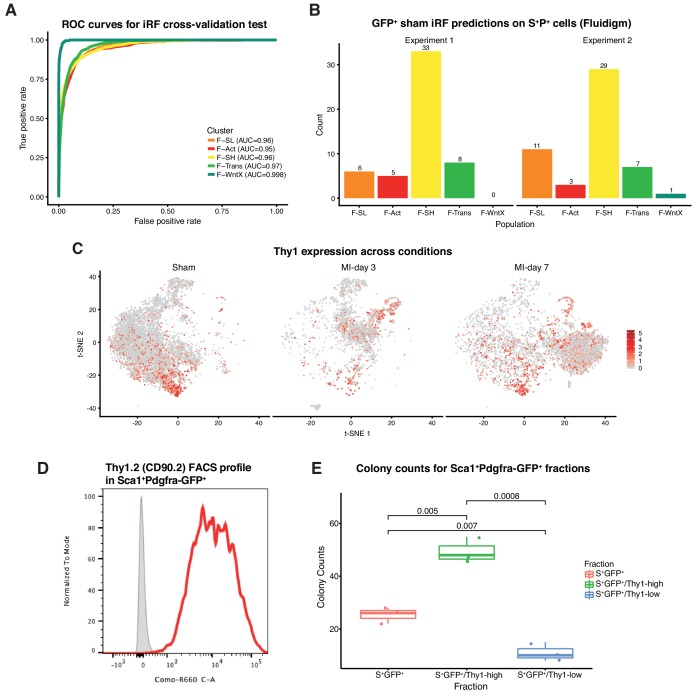
Comparison of GFP+ populations with FACS-sorted S+P+ cells.(A) ROC curves showing prediction accuracy of iRF classifier for predicting populations in sham cells. ROC calculated across a 10-fold cross-validation test. (B) Counts of iRF predicted cell identities across two scRNA-seq (Fluidigm) experiments on S+P+ cells. (C) Thy1 expression across conditions. (D) Distribution of Thy1.2 (CD90.2) protein expression by FACS in S+Pdgfra-GFP+cells. (E) Colony counts comparing S+Pdgfra-GFP+ with Thy1.2 fractions (low vs high) isolated by FACS (n = 3). Indicated p-values are derived from Student’s t-test.